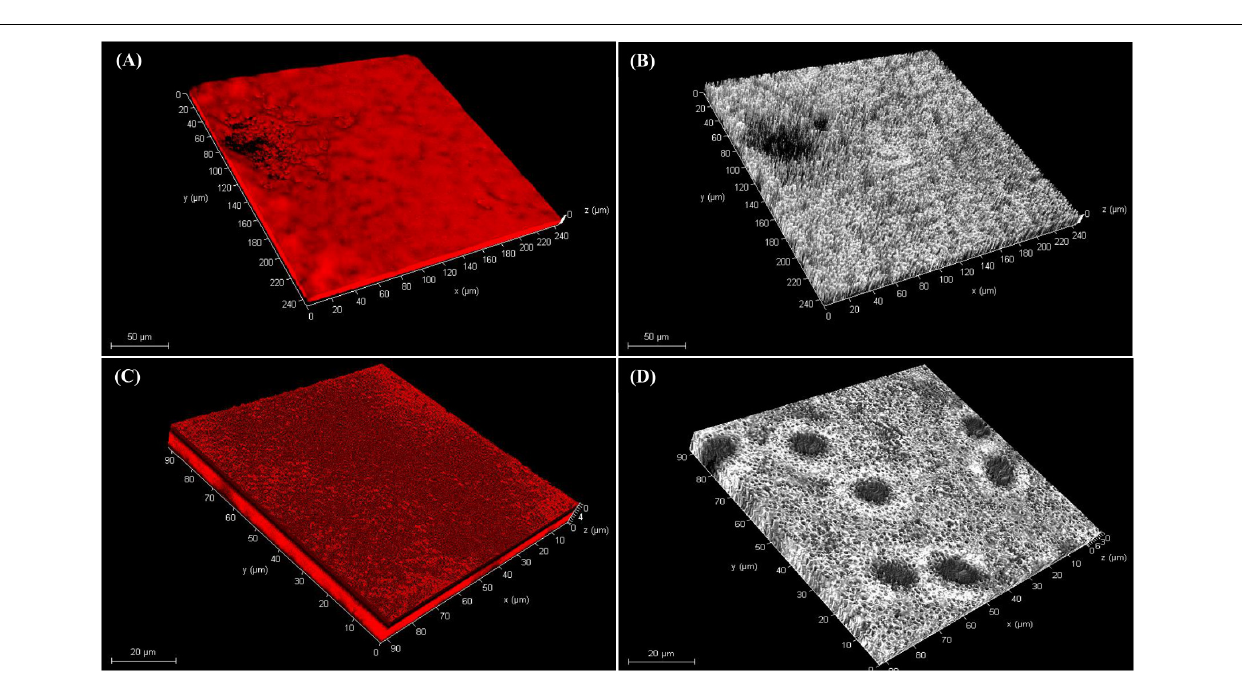
spread, irregularly shaped colony at 100X